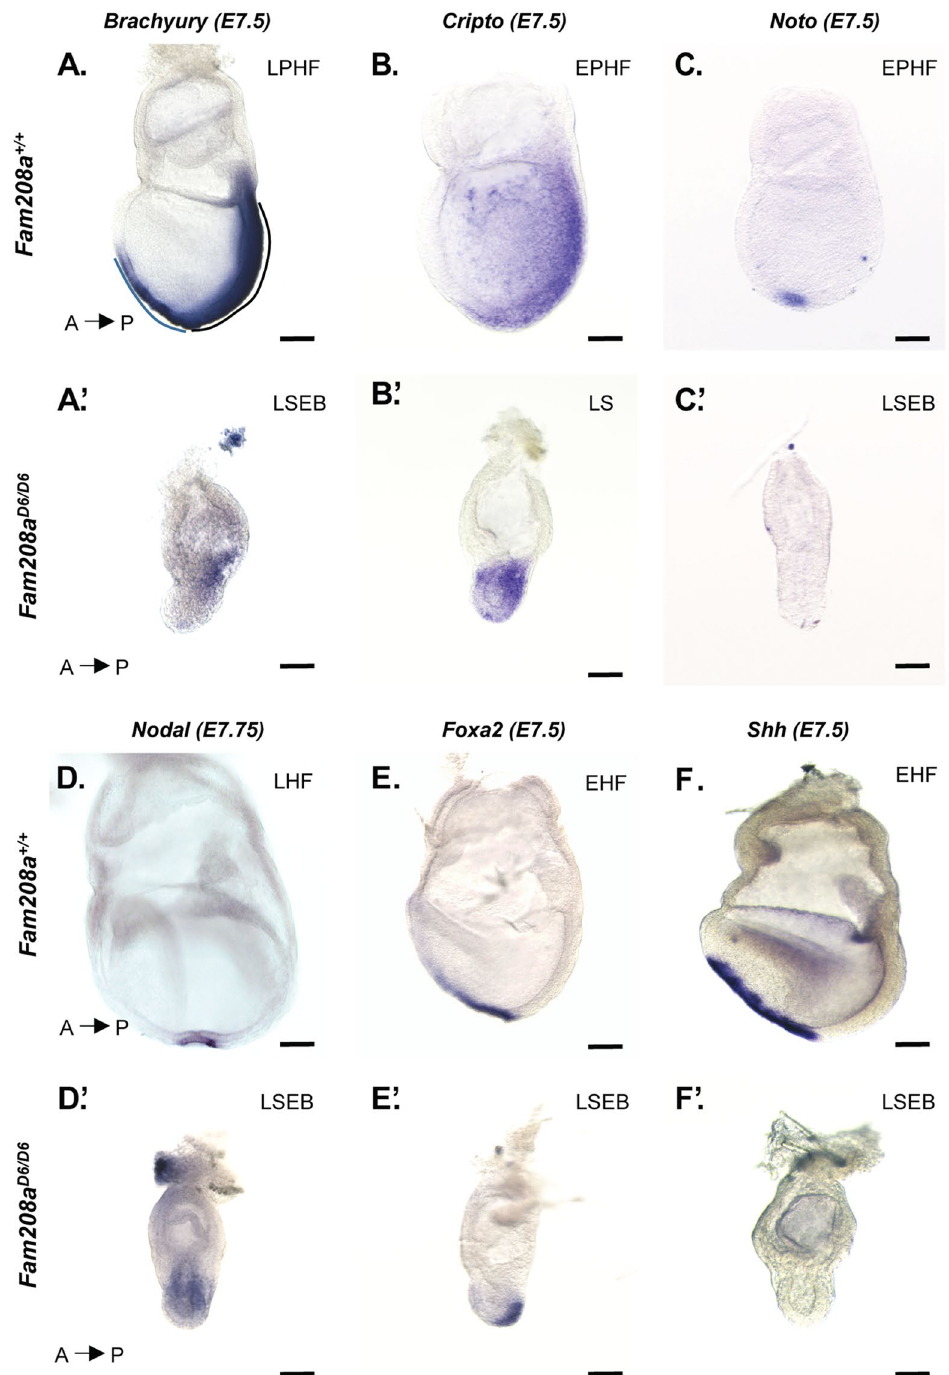
Figure 1. Fam208a D6/D6 mutants exhibit gastrulation failure defects. Whole mount in situ hybridization at E7.5-E7.75 of Fam208a D6/D6 mutants ( A’–F’ ) and their wild-type littermate controls ( A–F ). The Fam208a D6/D6 mutant embryos at E7.5 are phenotypically distinguishable with severely retarded epiblast. ( A’ ) In mutants, PS initiates but remains hardly 1/3 rd in its length with no distal and anterior expression as seen by Brachyury expression (pan-mesodermal marker). ( B’ ) Cripto , a PS and nascent mesoderm marker is expressed slightly delayed in mutants. Together, they show arrested PS elongation. ( C’, D’ and F’ ) The expression of Noto, Nodal and Shh is undetectable in the node of the Fam208a D6/D6 mutant embryos with ( G’ ) reduced anterior expression of AME marker Foxa2 . Line indicates the length of the PS. Dashed line in black demarcates the length of the PS and the blue dashed line indicates the node and head process. Scale bar: 30 µ m. PS, primitive streak, LPHF, Late pre-head fold; LSEB, Late streak, early allantoic bud; LS, Late-streak; EPHF, Early pre-head fold; LHF, Late Head fold; EHF, Early head fold; al, Allantois. Also, see Supplementary Figs